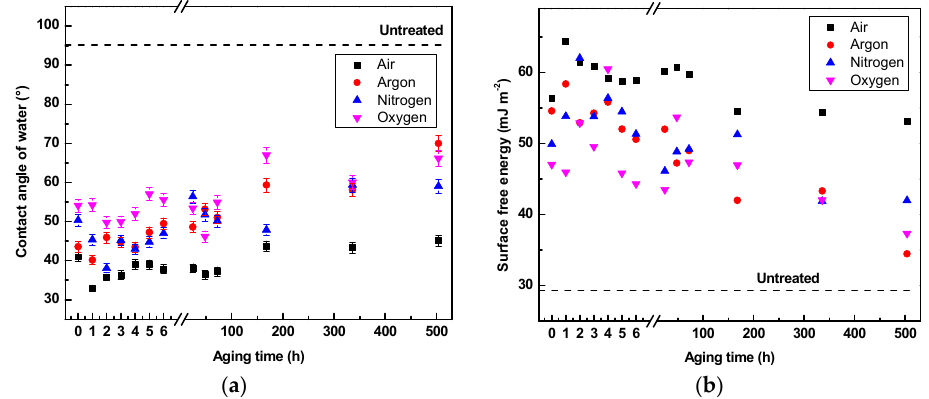
Figure 8. Surface wettability of LDPE treated for 120 s using different gases and stored in water: ( a ) contact angle; ( b ) surface free energy (SFE).